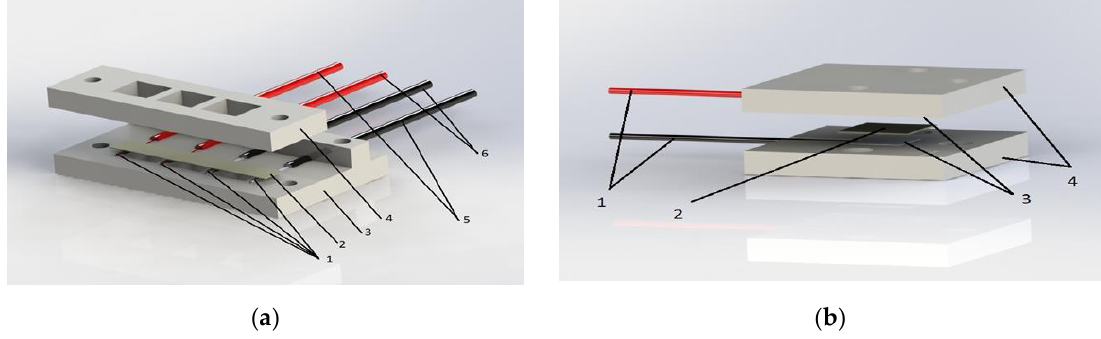
Figure 1. Schematic images of cells used in impedance spectroscopy studies for in-plane and through-plane geometries of the polymer film. In-plane geometry ( a ): 1, platinum contacts (5, current; 6, potential); 2, membrane; 3, bottom Teflon plate; 4, upper Teflon plate. Through-plane geometry ( b ): 1, platinum contacts; 2, membrane; 3, platinum foil; 4, upper and bottom Teflon plates.